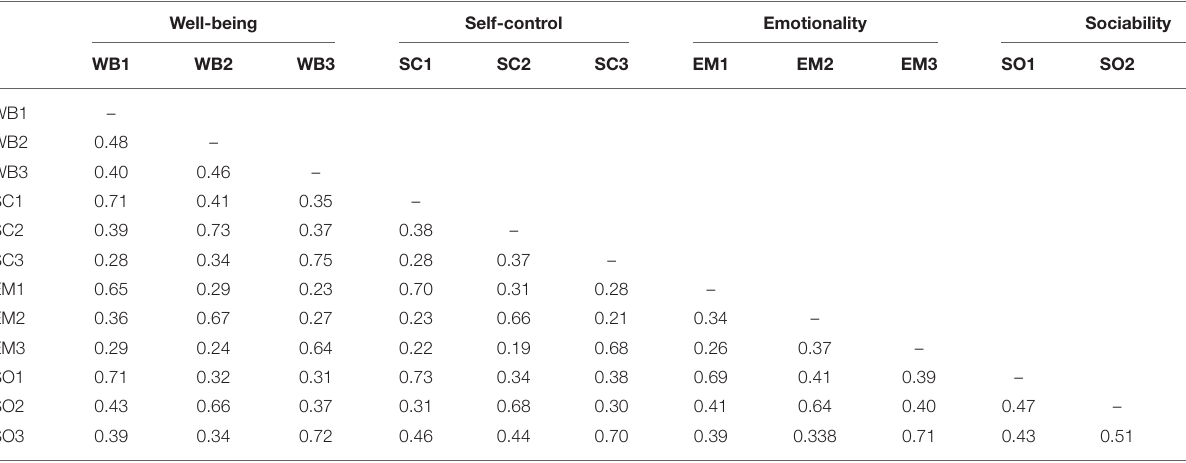
WB, well-being; SC, self-control; EM, emotionality; SO, sociability.